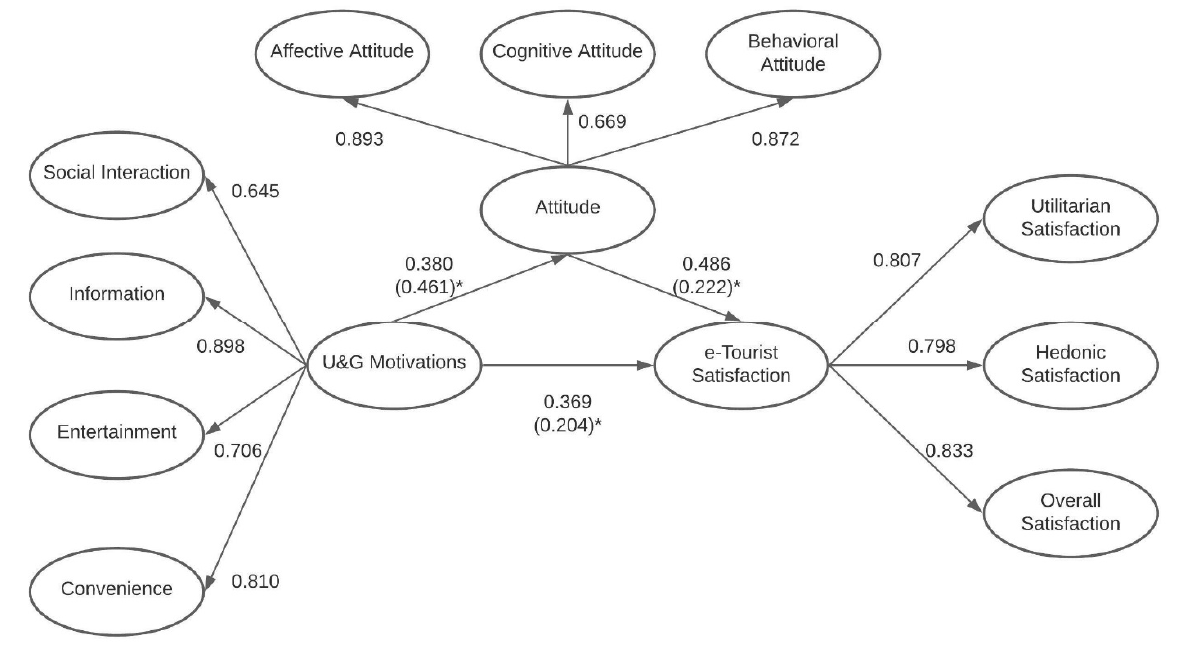
Figure 2. Standardized and Unstandardized Coefficients of the Level 1 SEM.